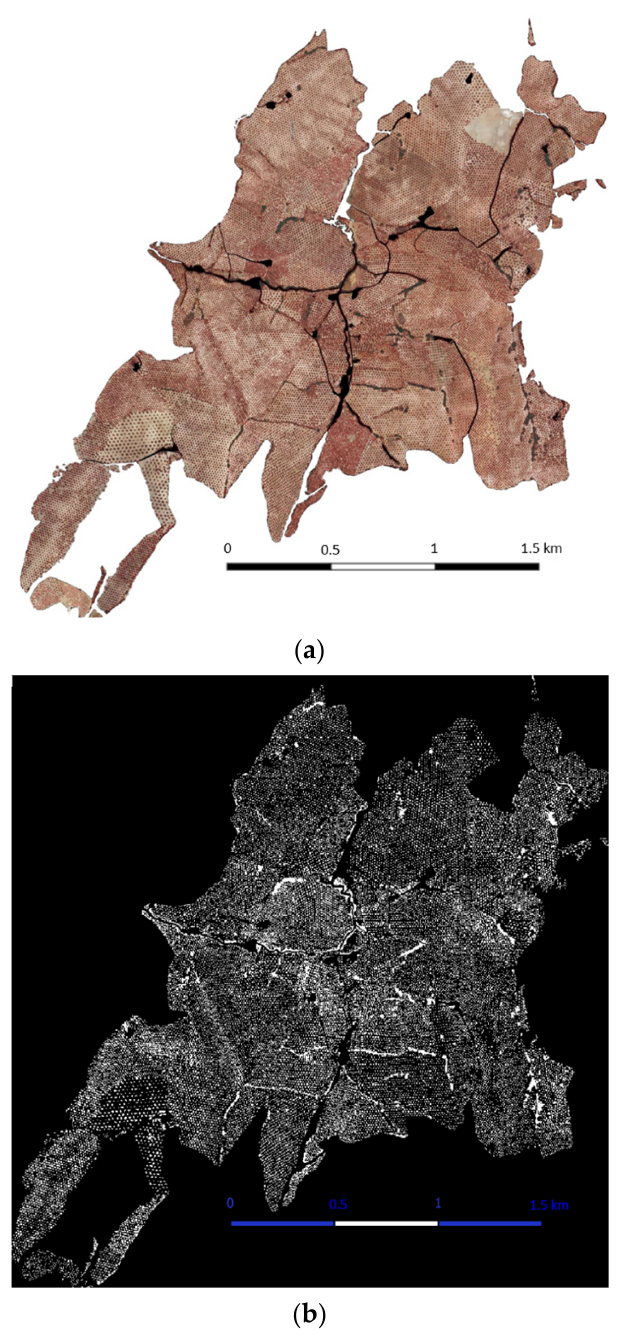
Figure 9. Example of processing a polygon (14,55,17) belonging to Córdoba: ( a ) Control image generated by the tool; ( b ) Binary mask with identified trees. Table 4. RAIF cultivated area data vs SIGPAC cultivated